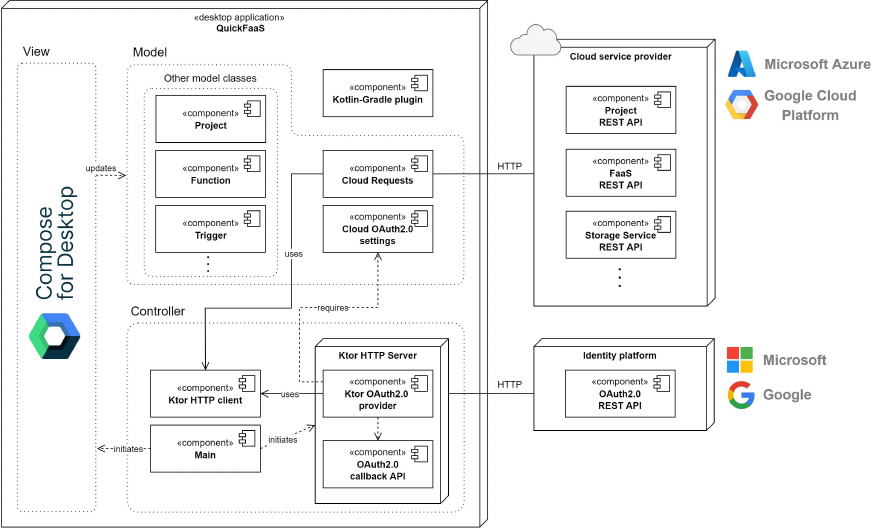
Figure 8. Deployment